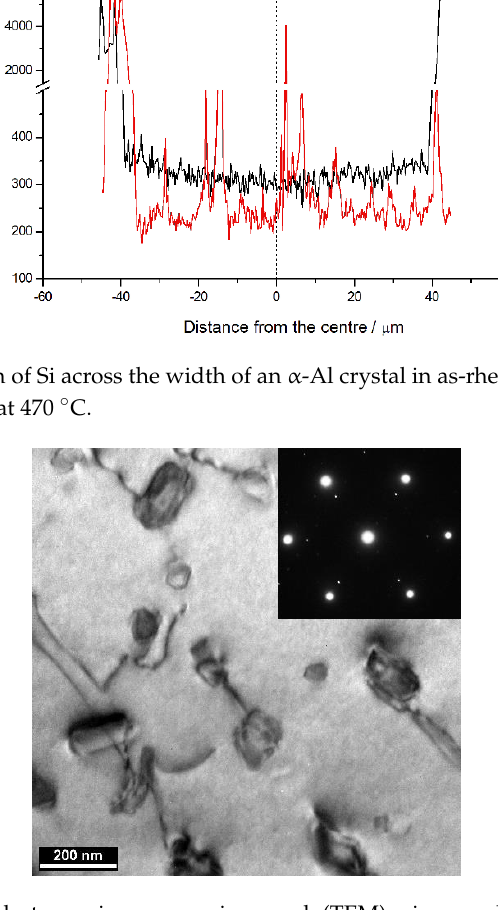
Figure 10. Transmission electron microscopy micrograph (TEM) micrograph showing Si dispersoids within the α -Al matrix in the rheocast AlSi9Cu3(Fe) alloy after solution treatment at 470 °C for 6 h. In the inset, the selected area electron diffraction (SAED) pattern acquired from a Si dispersoid is reported.